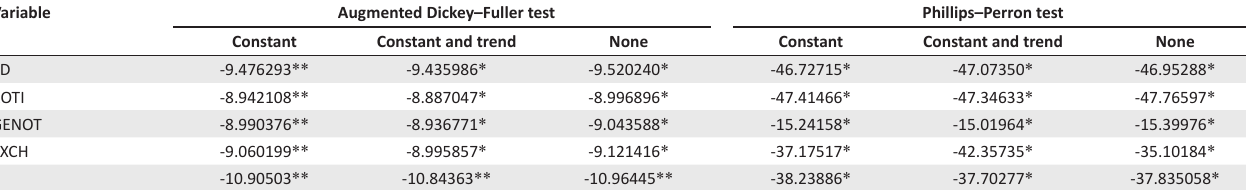
TABLE 2: Unit root tests: First difference series.